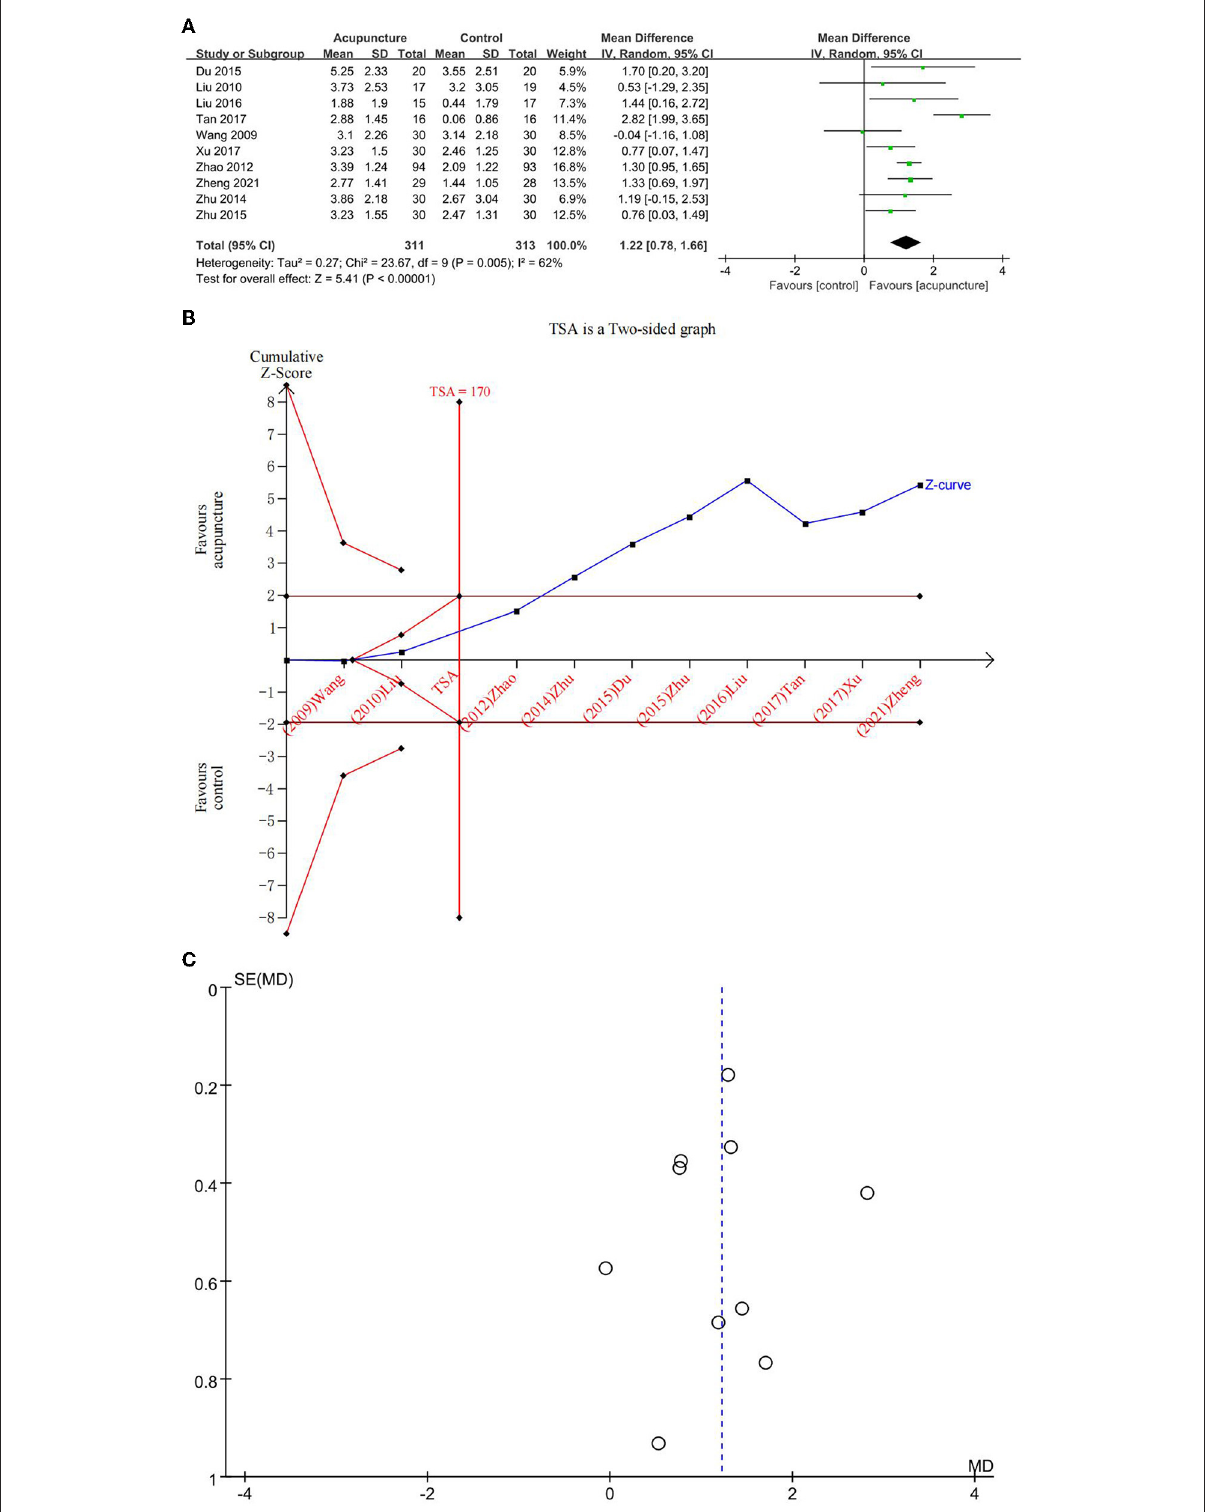
FIGURE3 (A) Forest plot of improvement of Mini-Mental State Examination (MMSE); (B) trial sequential analysis of improvement of MMSE; and (C) a funnel plot of improvement of